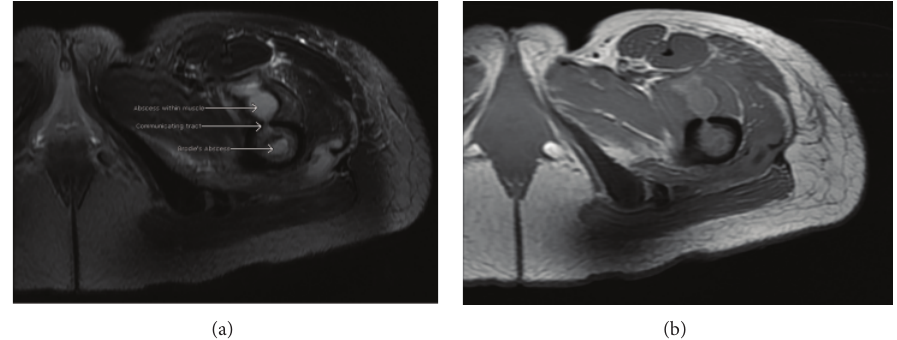
Figure 1: Axial views of MRI showing the Brodie’s abscess in the left proximal femur, with a break in the cortex and a tract communicating with the abscess and overlying muscle. (a) T2-weighted image; (b) T1-weighted